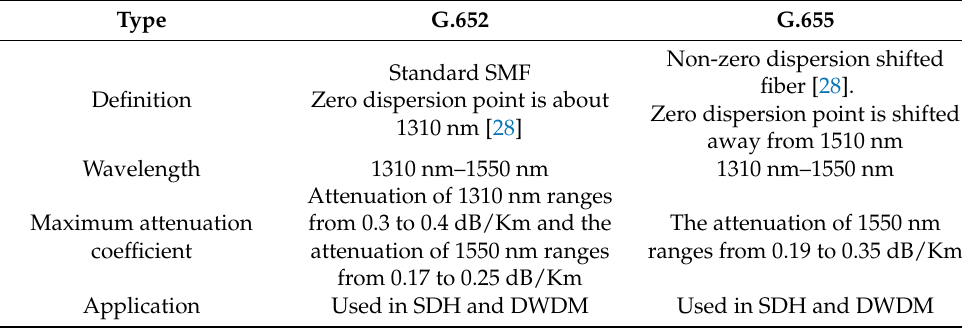
Table 6. The specifications of single mode fiber standard types specified by